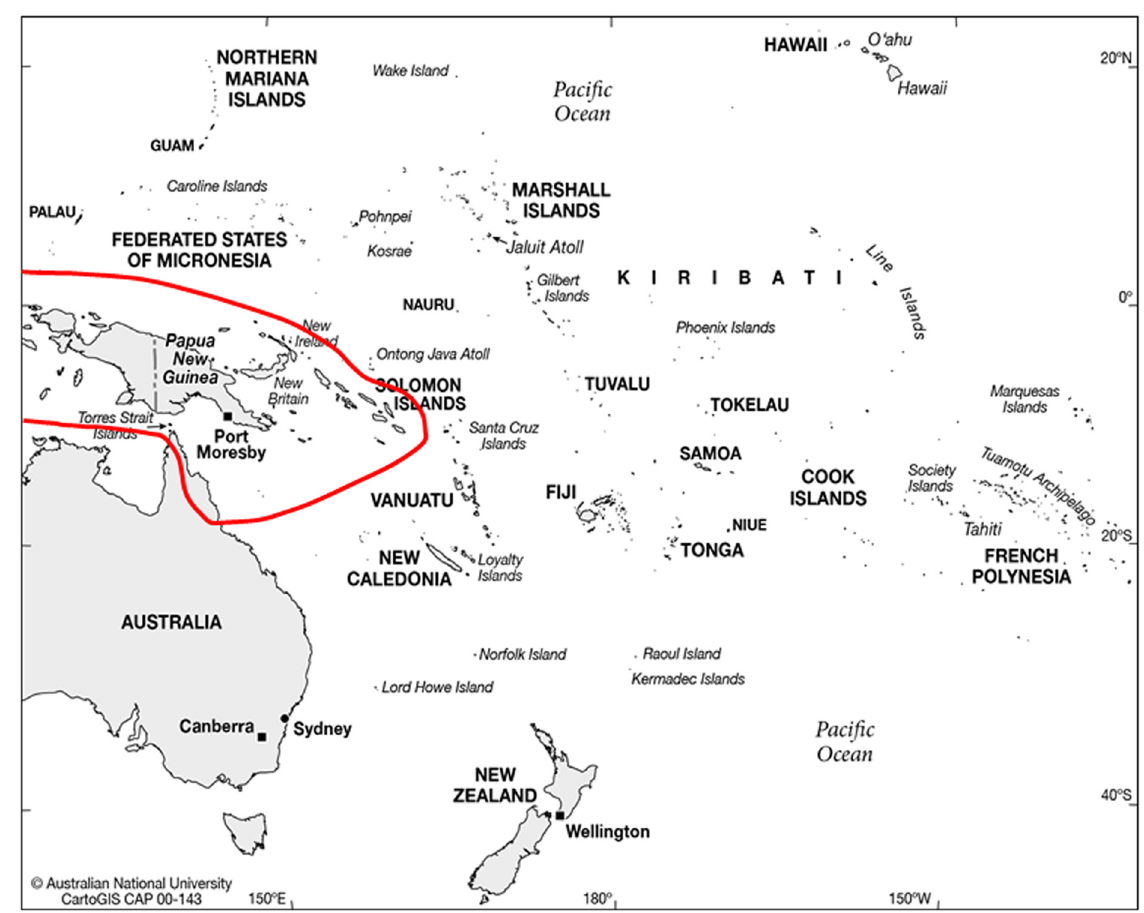
Fig. 16. Regional distribution of the genus Polyalthia (Annonaceae) in the Pacific. Base map sourced from CartoGIS, College of Asia and the Pacific, The Australian National University,